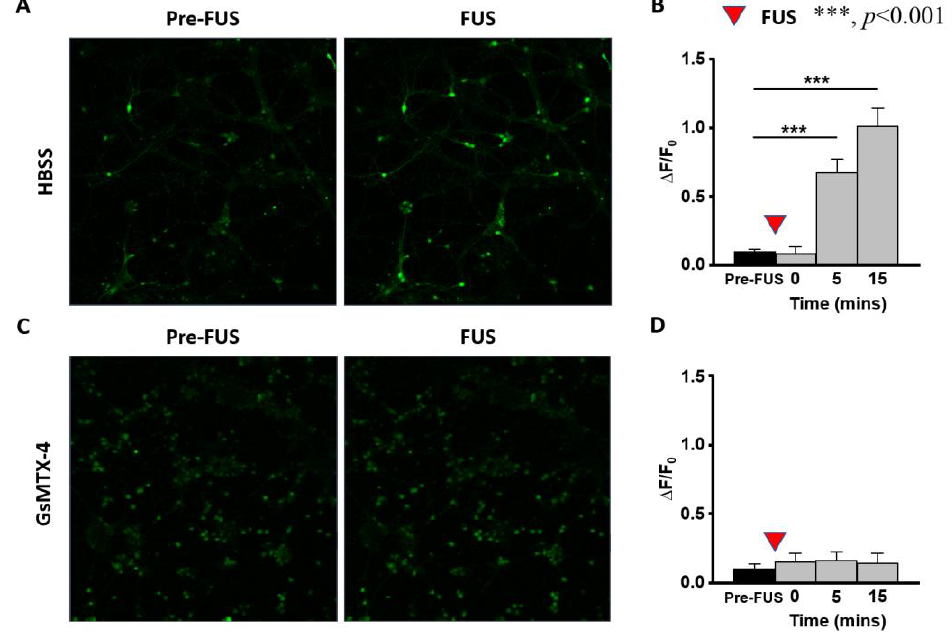
Figure 6. Calcium images of primary neurons following weak ultrasound sonication (I SPTA = 12.15 mW/cm 2 ). ( A ) Representative images of Fluo-4-AM fluorescence presenting calcium signals in pri- mary neurons before and after weak sonication. ( B ) Quantitative analysis indicates that weak soni- cation increases the levels of calcium signals in primary neurons within 20 min. Bars represent mean ± SD from two experiments. (n = 66, *** represents p < 0.001, Friedman test post hoc Tukey test). ( C ) Re presentative calcium images of primary neurons pretreated with 5 μM GsMTx -4 before and after weak sonication. ( D ) Quantitative analysis indicated no increased calcium signals in primary neu- rons pretreated with GsMTx-4 after weak sonication within 20 min. Bars represent the mean ± SD from three experiments. (n = 219. *** represents p < 0.001, one-way repeated-measures analysis post hoc Tukey test). ΔF/F0: fluorescence changes/before weak sonication .